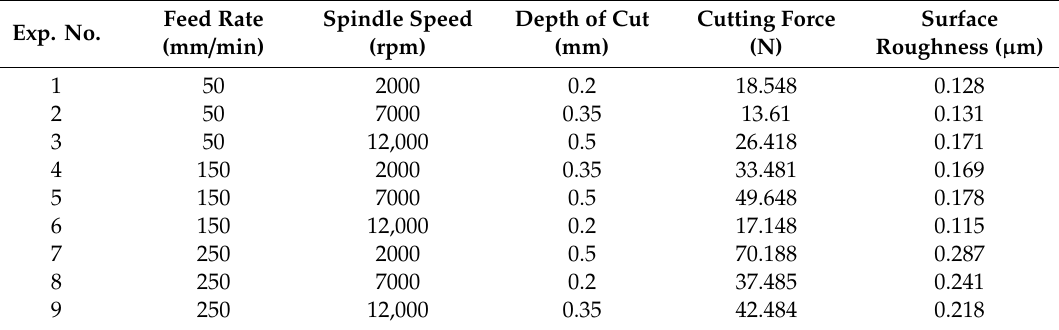
(cid:16) (cid:17) Table 4. L 9 3 4 Experimental results of the cutting force and surface roughness. Exp.